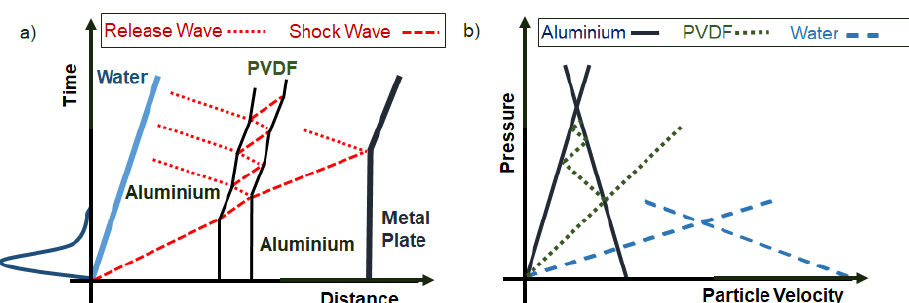
Figure 4. x-t (distance-time) diagram ( a ) and P-u (pressure-particle velocity) diagram ( b ) describing the interaction of an assumed planar shock with constitutive layers of the sensor. Shocks and release waves are in red. The primary shock comes from water, goes through aluminium shield, PVDF and aluminium before being reflected. The successive states reached by the PVDF are represented through the P-u